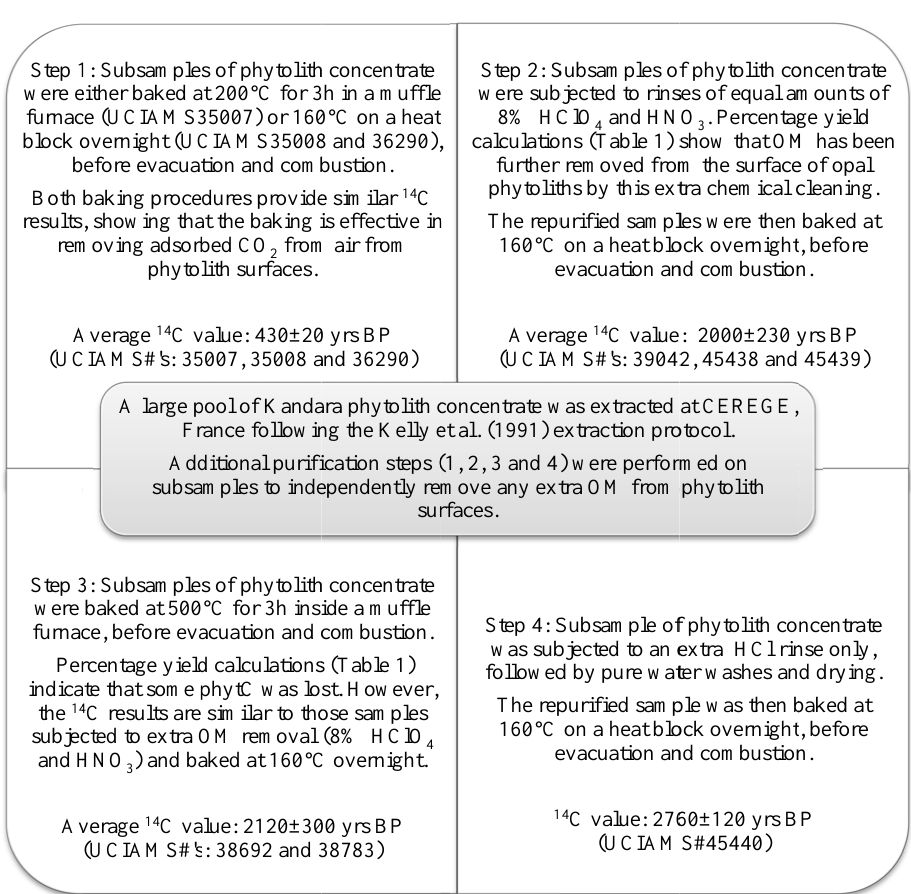
Fig. 1. Additional purification steps processed on the Kandara phytolith concentrate. Average of 14 C ages from repurified material is